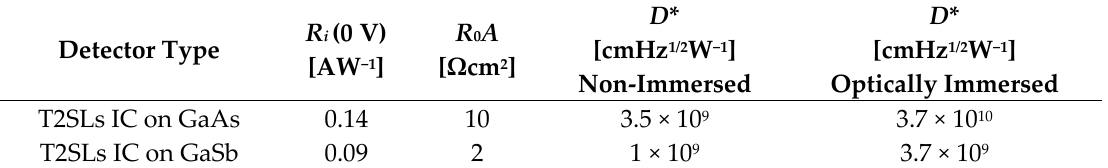
Figure 4. Power spectral density of current noise S i versus frequency, measured at bias voltage -5 mV for T2SLs based ICIPs grown on GaSb and GaAs substrates. Table 1. The D * of T2SLs based ICIPs operated at 300 K. Values of R i were taken at 4 μ